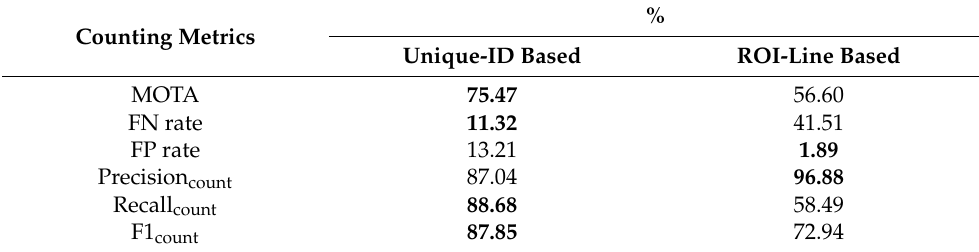
Table 9. Pear counting performance metrics of the pear counting system based on YOLOv4 and Deep SORT on a 1920 × 1080 video between the two approaches in counting: unique-ID based and region-of-interest (ROI) based. Values in bold face are the higher ones between the counting approaches.